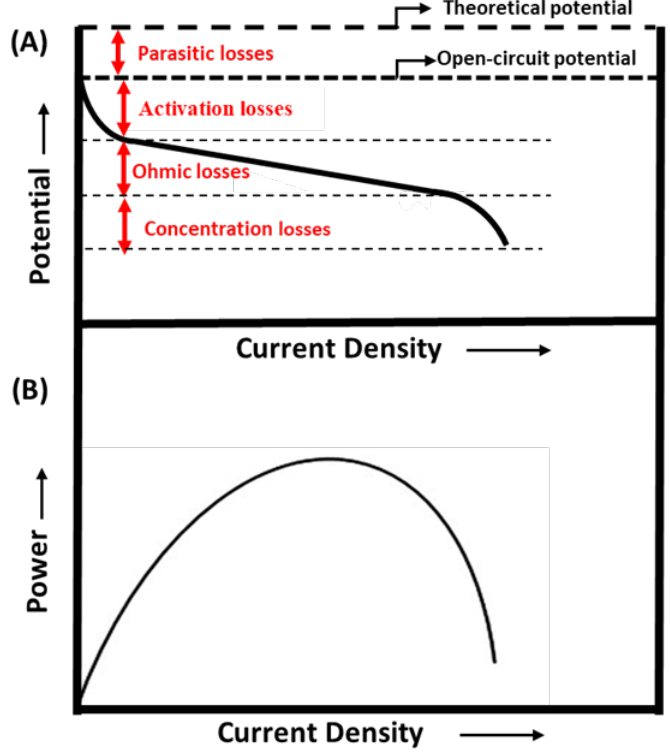
Figure 3. ( A ) Different types of cathodic overpotentials, ( B ) Power-current curve.